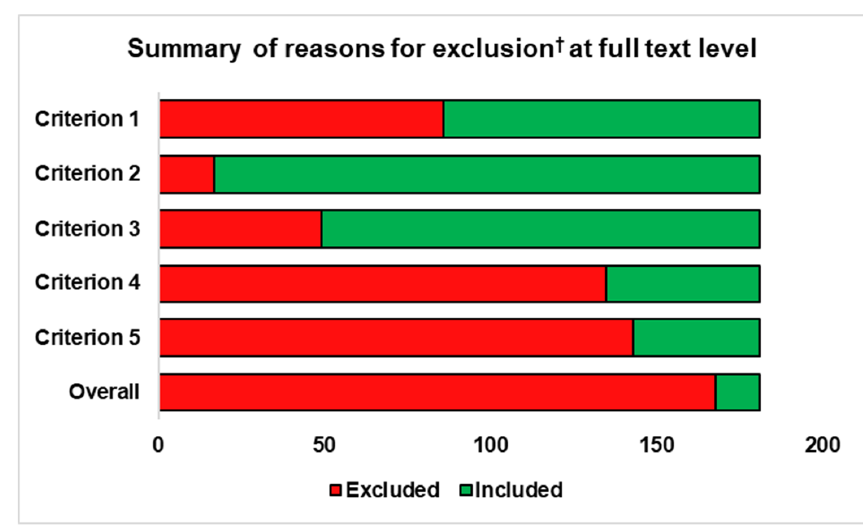
Figure 2. Summary of the secondary screening of full text articles investigating the effect of high-speed exercise history (HSEH) on musculoskeletal injury (MSI).